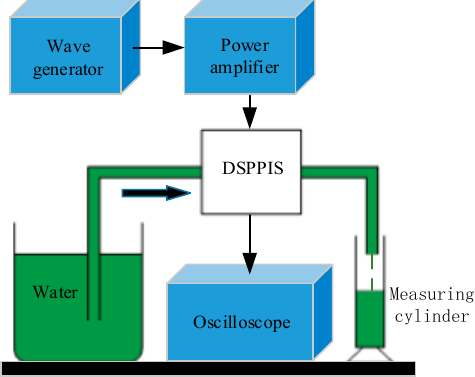
Figure 4. The schematic of the self-sensing test of the DSPPIS.